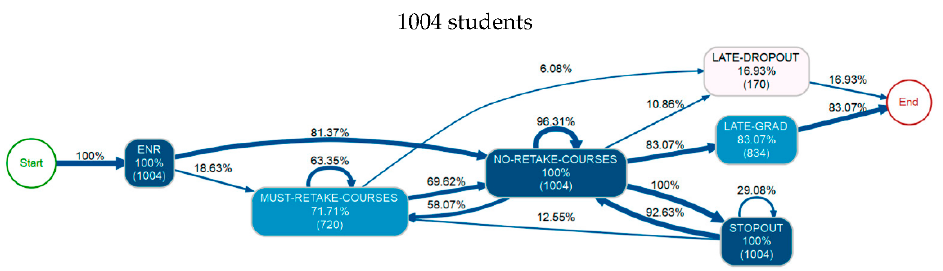
Figure 4. Educational trajectories in high-failure rate courses, according to the RETAKE-STOPOUT model, including only students who had at least one NO-RETAKE-COURSES > STOPOUT transition, did not have MUST-RETAKE-COURSES > STOPOUT transitions, and ended in LATE-DROPOUT or LATE-GRAD. The darker color of the nodes represents a higher percentage of students who went through a state. The thickness of the arrows represents the percentage of students who had transitions between both states. All values are percentages in relation to the total number of students included in each model.